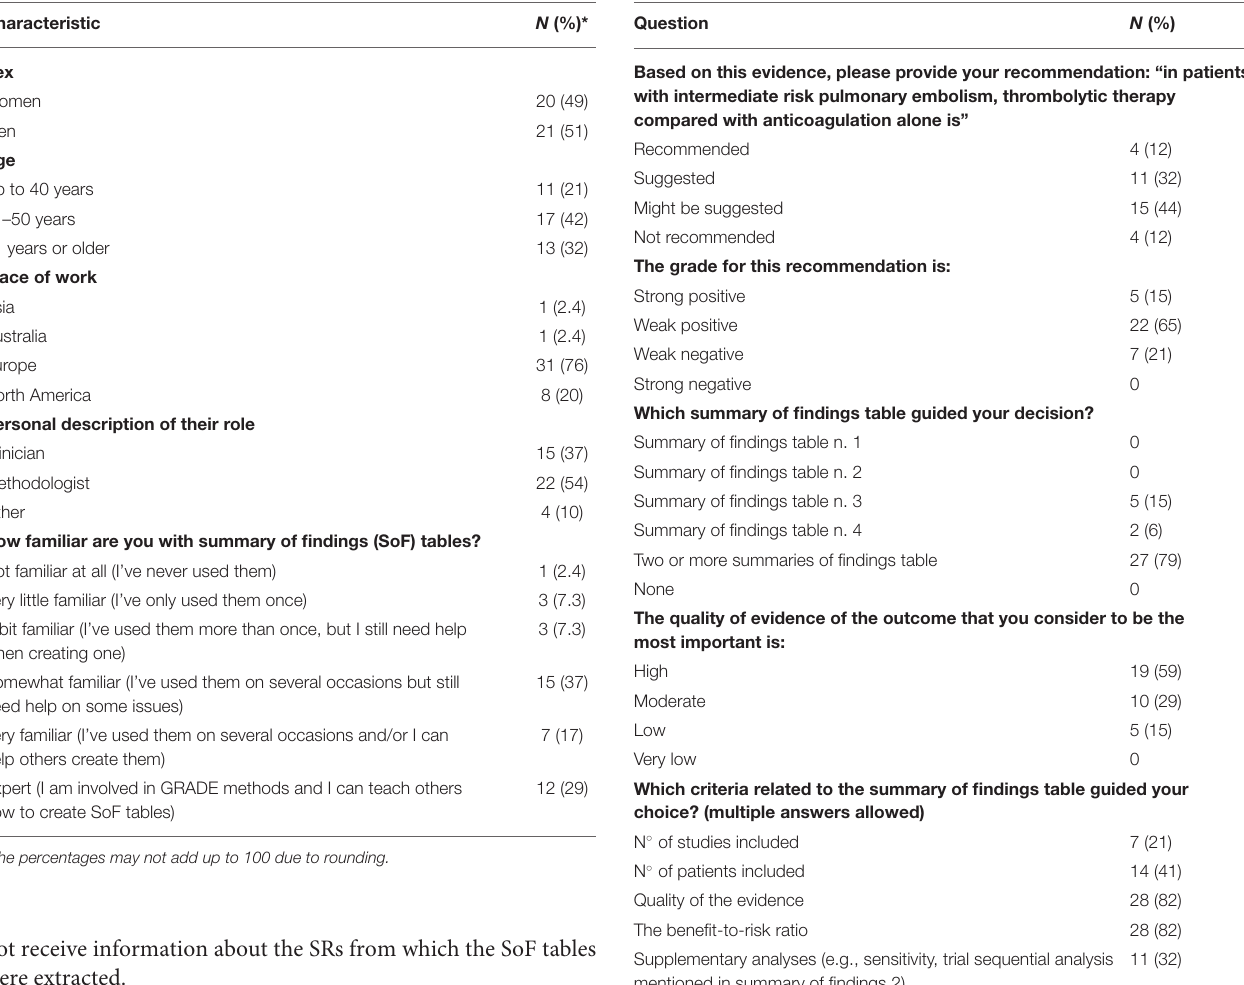
TABLE 1 | Characteristics of study participants (responses provided by all 41 participants).